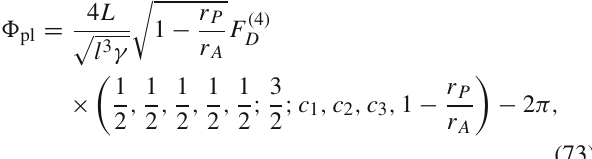
precession is given by (cid:30) pl = 2 φ AP − 2 π , where φ AP is the azimuth angle swiped between r A and r P during the bound orbit. This way, one